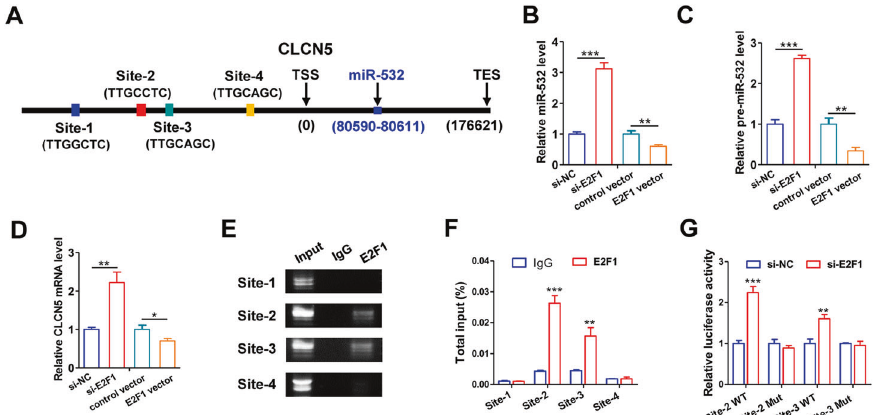
Fig. 6 miR-532 and E2F1 form a feedback loop. A Schematic illustrating the putative E2F1-binding sites in miR-532 promoter. B , C qRT-PCR analysis of miR-532 or pre-miR-532 levels in MKN-45 cells after changing E2F1 expression. D qRT-PCR analysis of CLCN5 mRNA levels in MKN- 45 cells after changing E2F1 expression. (E , F Direct binding of E2F1 to miR-532 promoter as indicated by ChIP assays. Binding was con fi rmed by semi-quantitative PCR, followed by gel electrophoresis. G Luciferase reporter assay con fi rmed the suppression of miR-532 promoter by E2F1. * P < 0.05; ** P < 0.01; *** P < 0.001. Cell Death and Disease (2022)